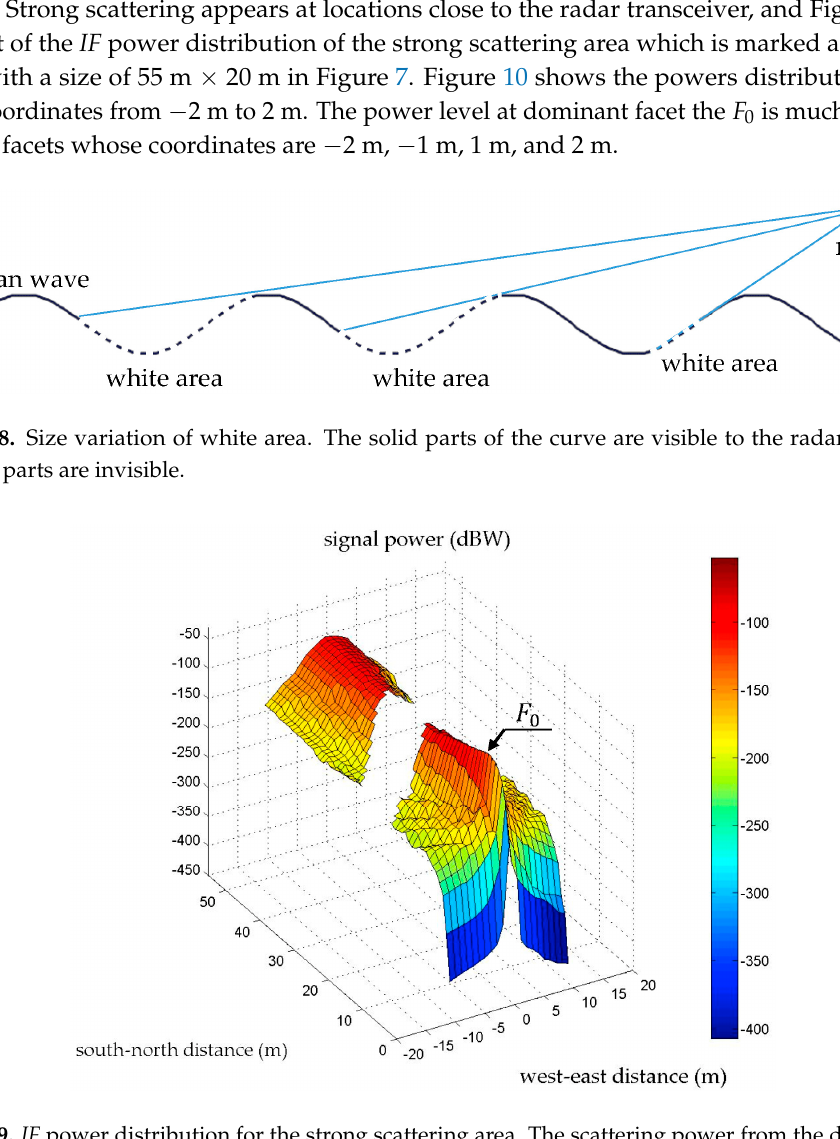
Figure 10. Power comparison around the dominant facet 𝐹 (cid:2868) . The absence of middle parts of the curves is due to the shadowed facets. The power levels at the dominant facet are much higher than the other four curves. Therefore, the scattering from side facets are negligible in the radar IF output.